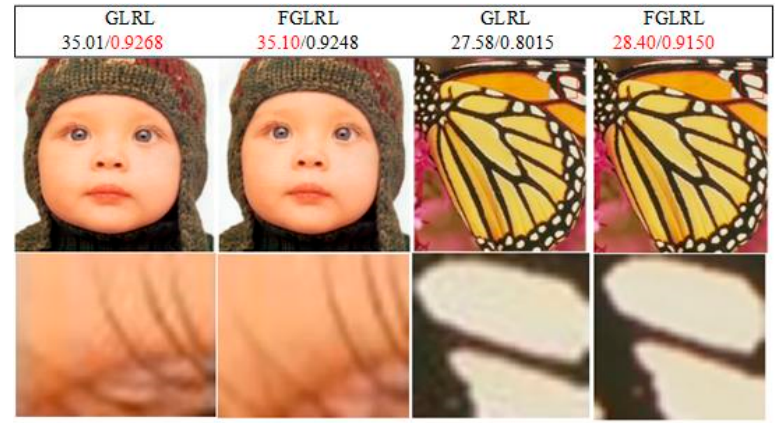
Figure 5. Qualitative comparison. The first image shows “baby” (Set5 with scale factor ×3). The second shows image “butterfly” (Set5 with scale factor ×3). Table 3. Comparison of PSNR, SSIM and running time values for GLRL and FGLRL on Set5.